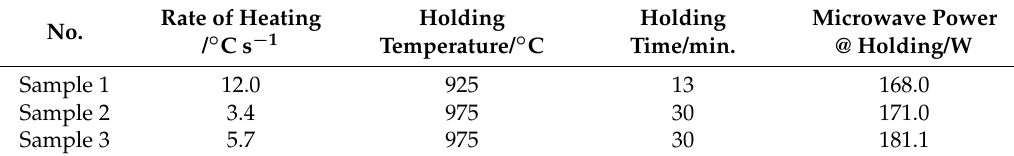
Table 2. Experimental conditions in microwave processing.